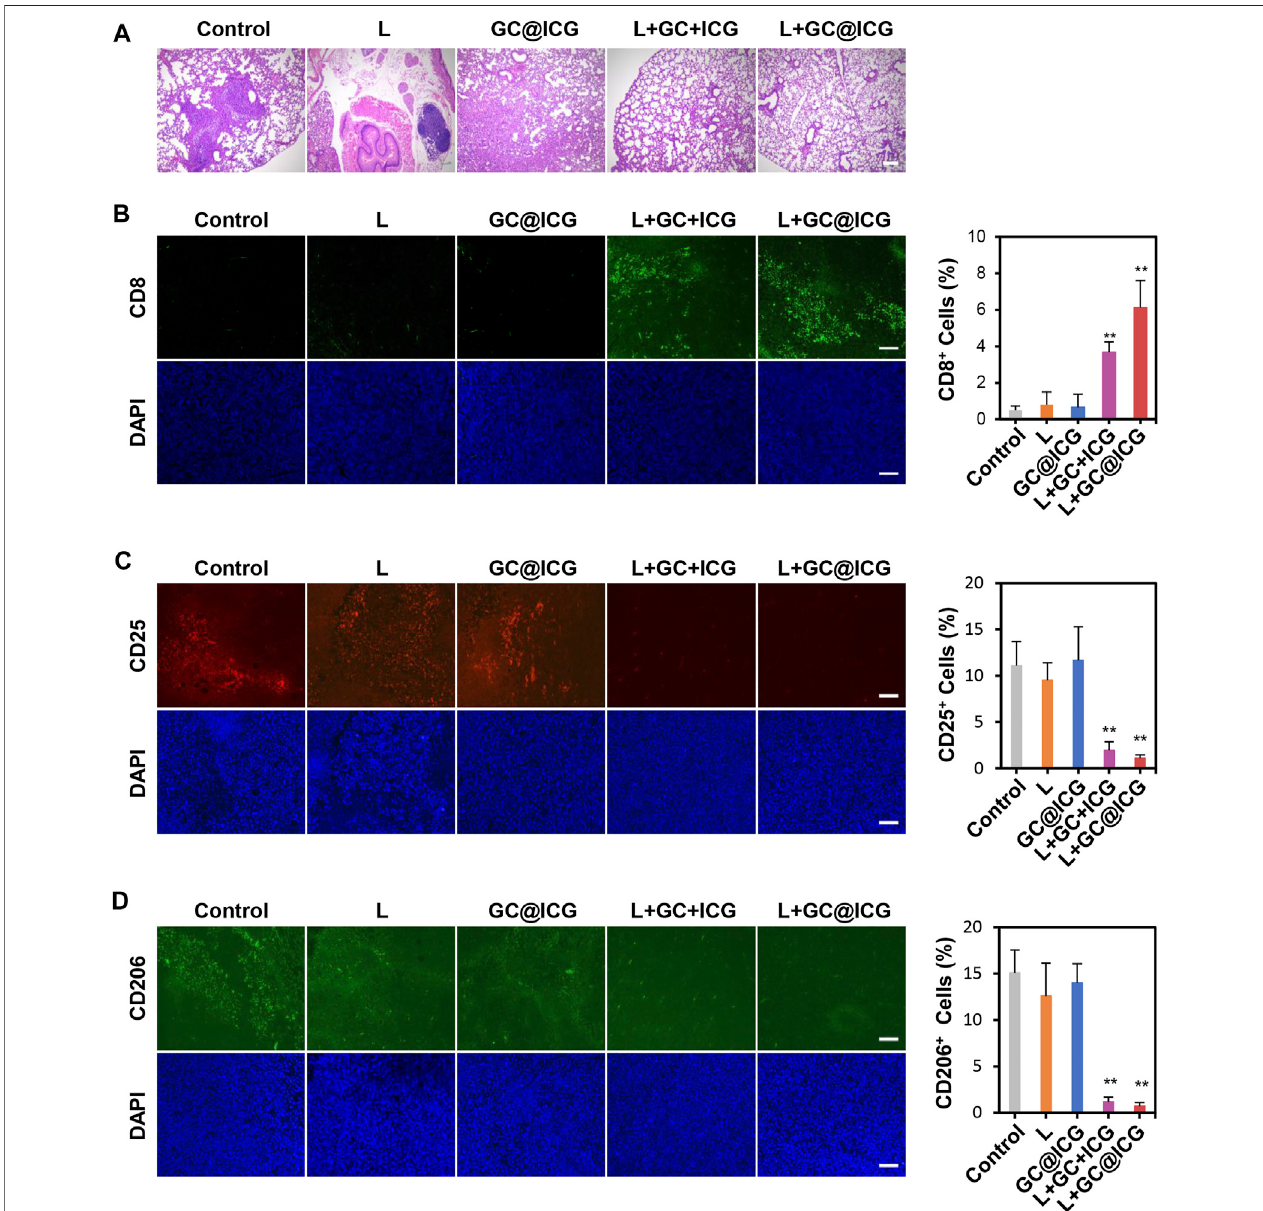
FIGURE 5 | Abscopal effect of GC@ICG-based phototherapy. (A) H&E staining images of lungs collected from mice after different treatments. Scale bar: 200 μ m. Immuno fl uorescence images of the excised distant tumor stained with anti-CD8a (B) , anti-CD25 (C) , and anti-CD206 (D) . Bar graphs showed the number of CD8 + , CD25 + , and CD206 + cells in fi ltrated in distant tumors. Scale bar: 100 μ m ( n = 3, pp p < 0.01).